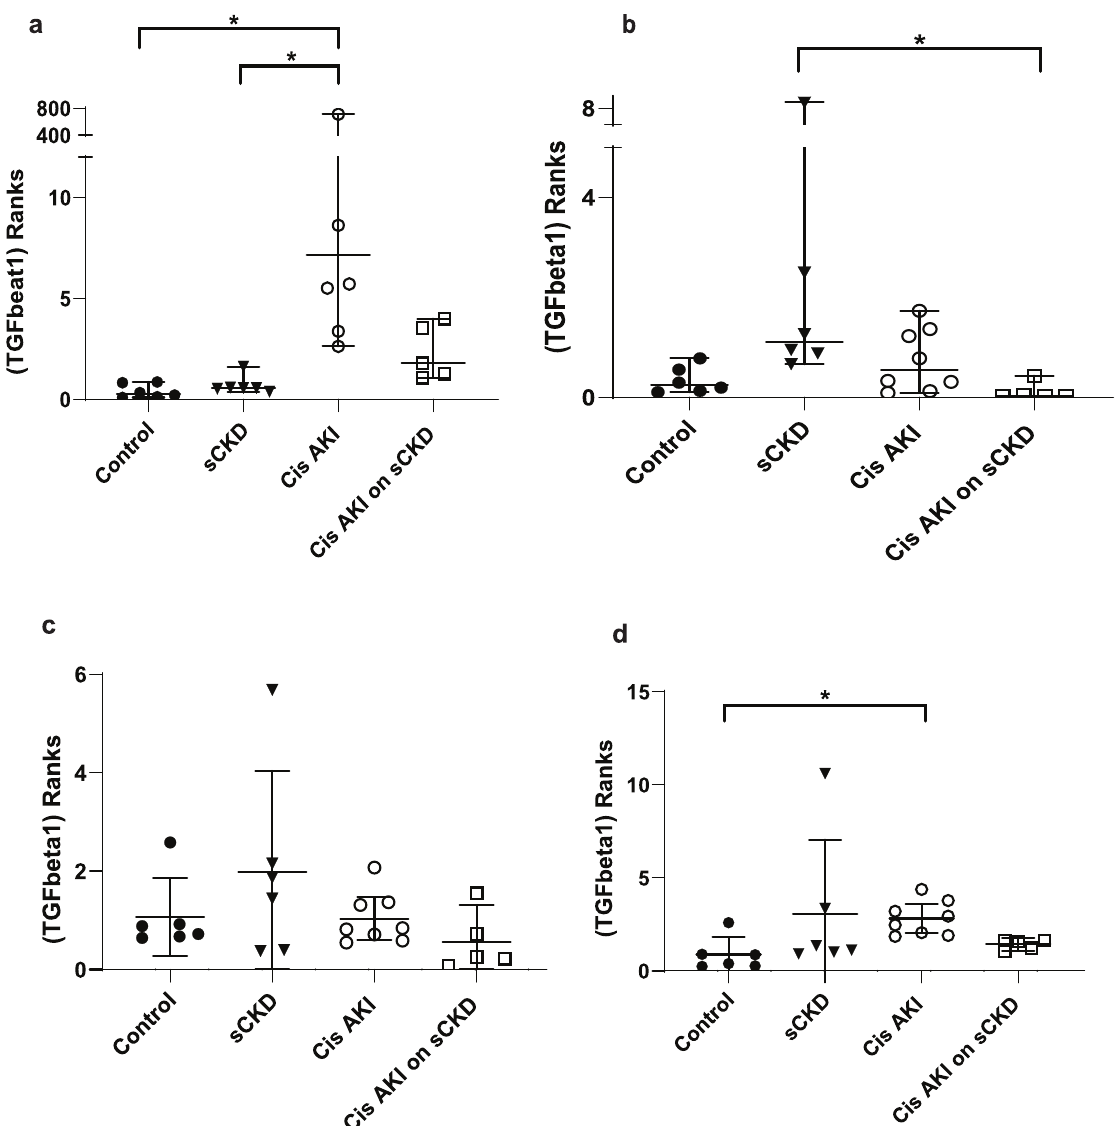
Fig 8. Rank difference between groups of TGF β 1 expression after cisplatin and normalised to a) 18S , b) GAPDH , c) PABPN1×HMBS , d) ACTB×PABPN1 . Data are means (one-way ANOVA) or medians (Kruskal Wallis) and 95% CI (n � 6). � p < 0.05, �� p < 0.01, ��� p <